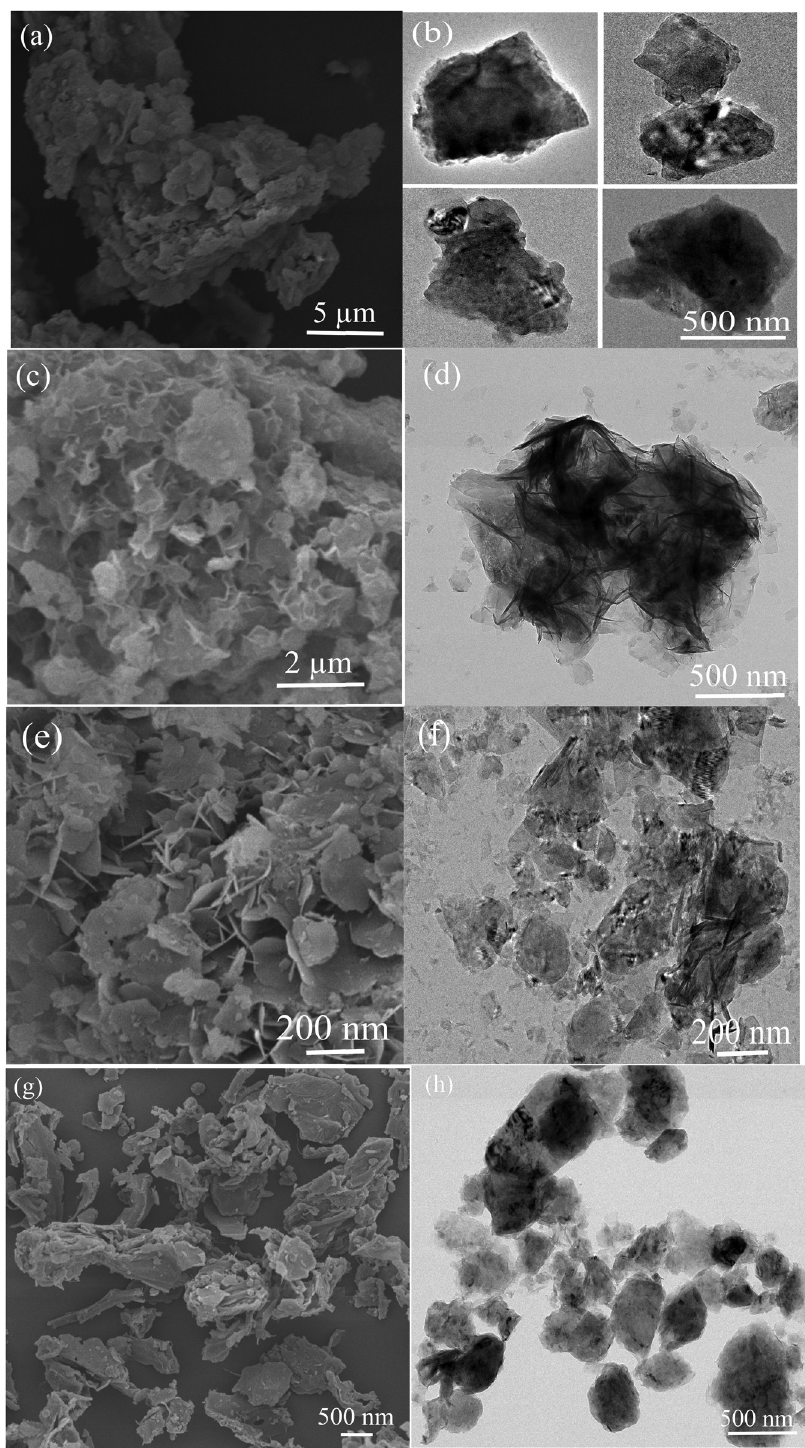
Figure 1: ( a, c, e, and g ) SEM and ( b, d, f, and h ) TEM images of ( a and b ) 50% B/LDHs, ( c and d ) 10% B/LDHs, ( e and f ) Mg – Al LDHs, and ( g and h ) soybean